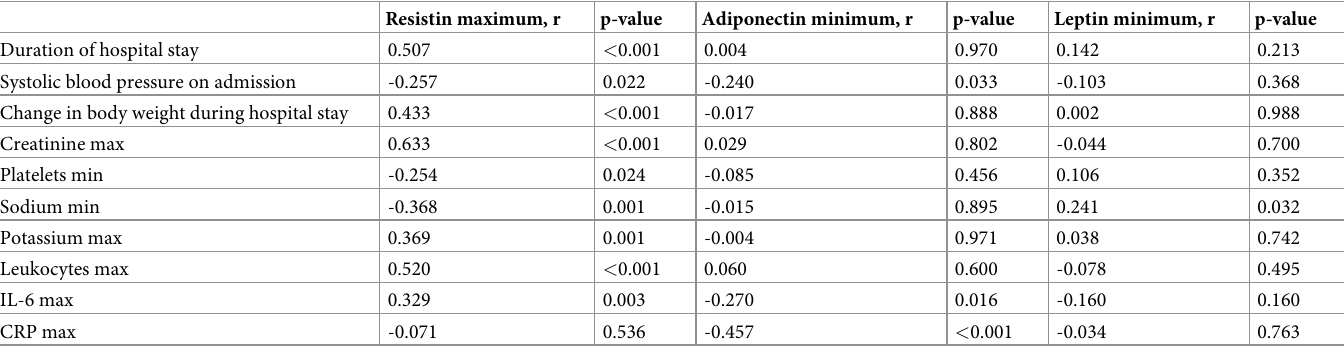
Table 3. Correlations of plasma resistin concentration with clinical and laboratory markers of disease severity in acute Puumala hantavirus